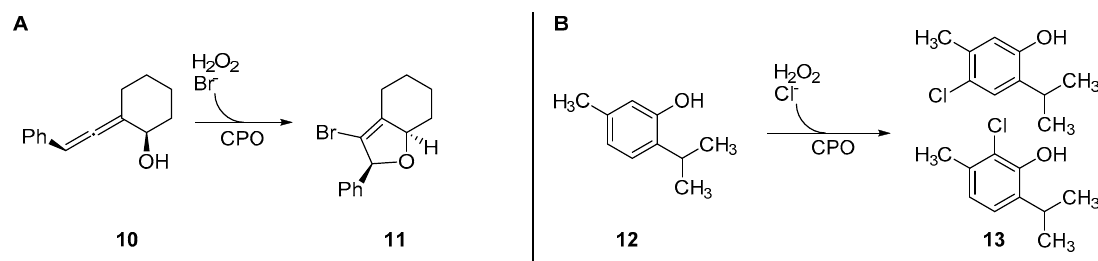
Figure 8. Example reactions of Cf- CPO involved in biocatalytic conversions of organic molecules ( A ): Cyclization of allenes ( 10 ) to the product 11 induced by halogenation with Br − by Cf- CPO. ( B ): Unselective chlorination of thymol ( 12 ) by Cf- CPO.